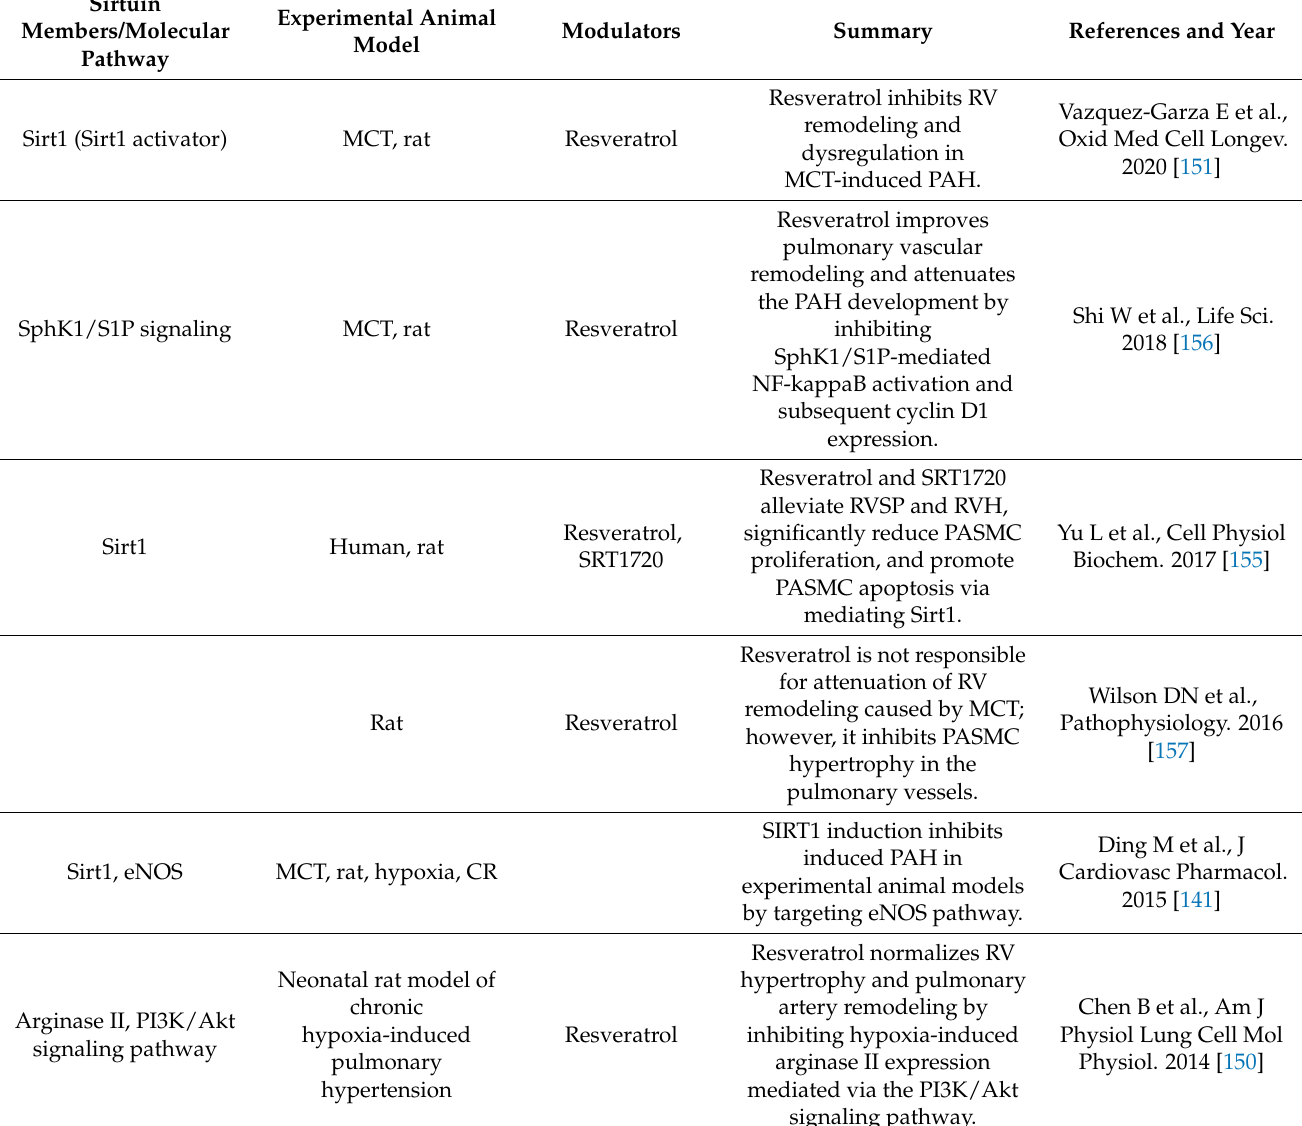
Table 1. List of sirtuin modulators in PAH and